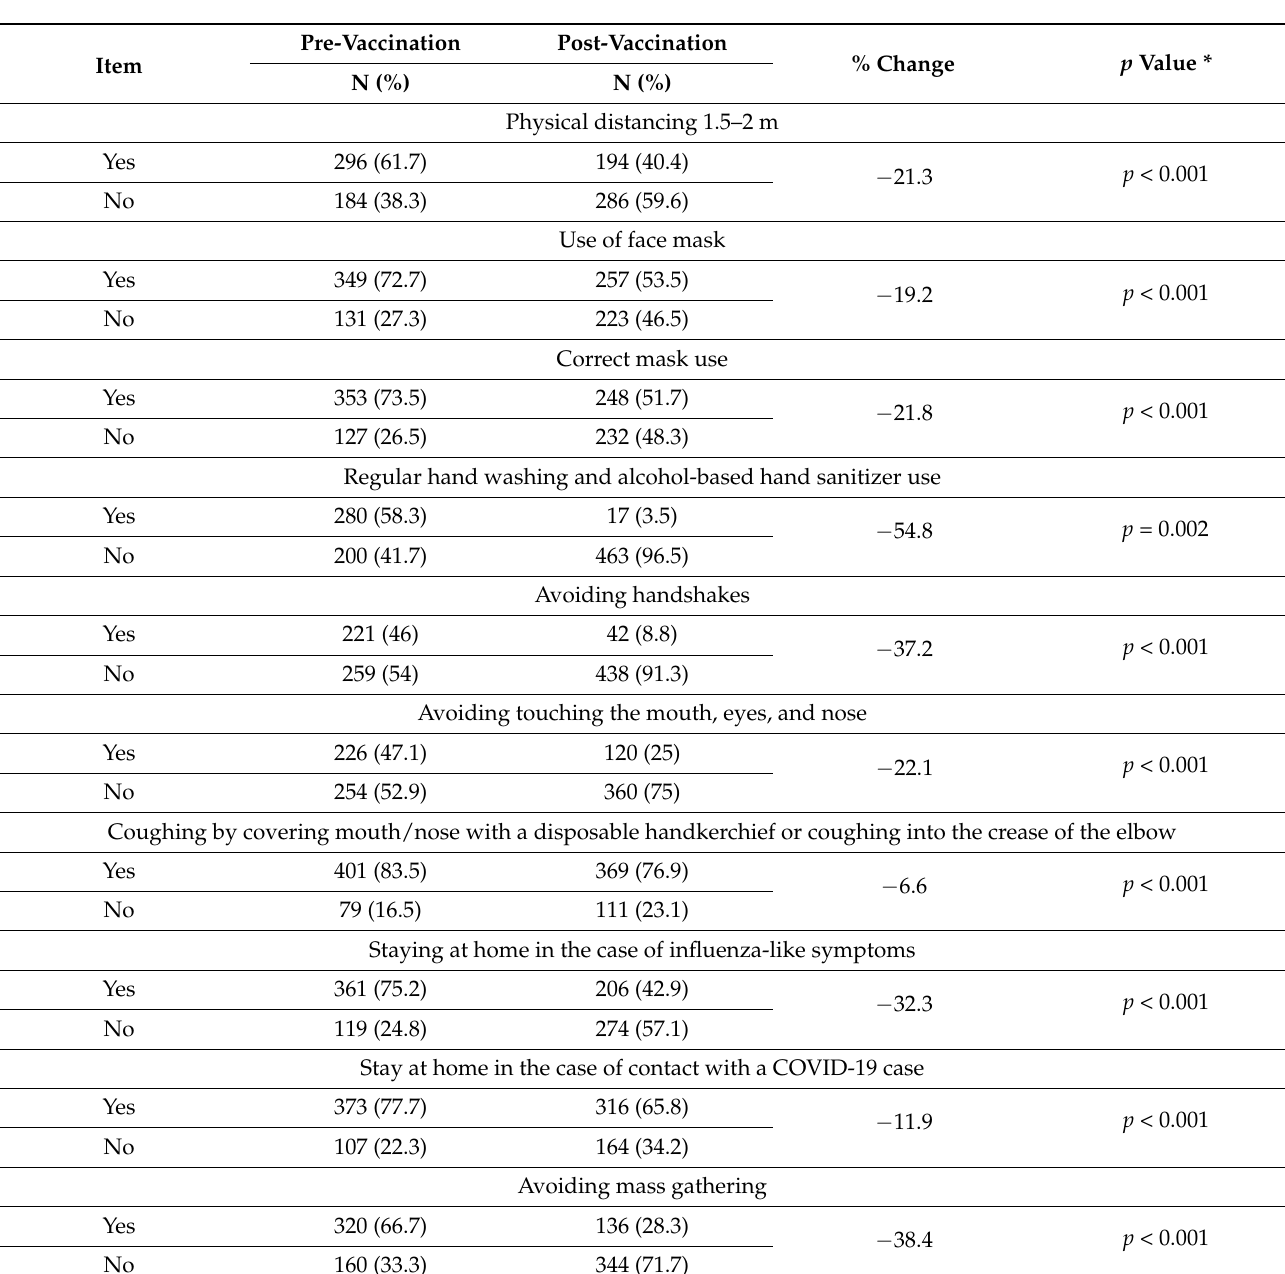
Table 3. Comparison of pre- and post-COVID-19 vaccination levels of adherence to personal protec- tive measures among 480 participants in the Jazan